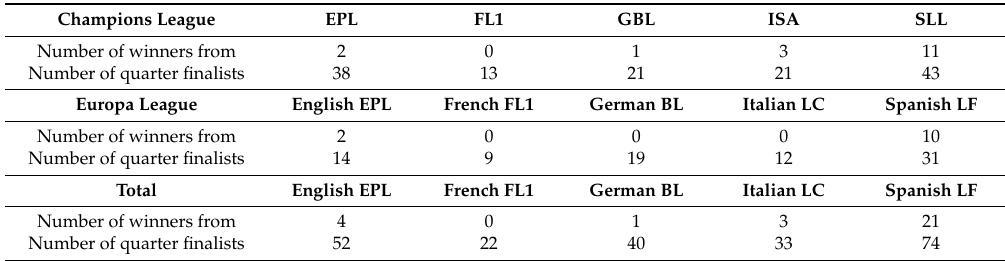
Table 1. The performance of major European leagues in UEFA competitions,